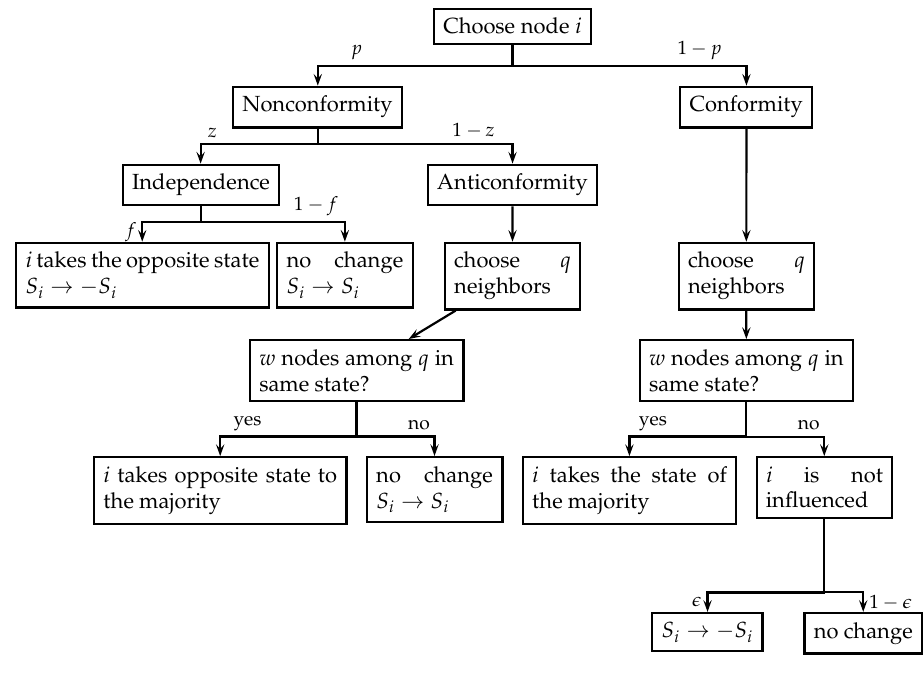
Figure 3. The q -voter model with nonconformity (adapted from [42])